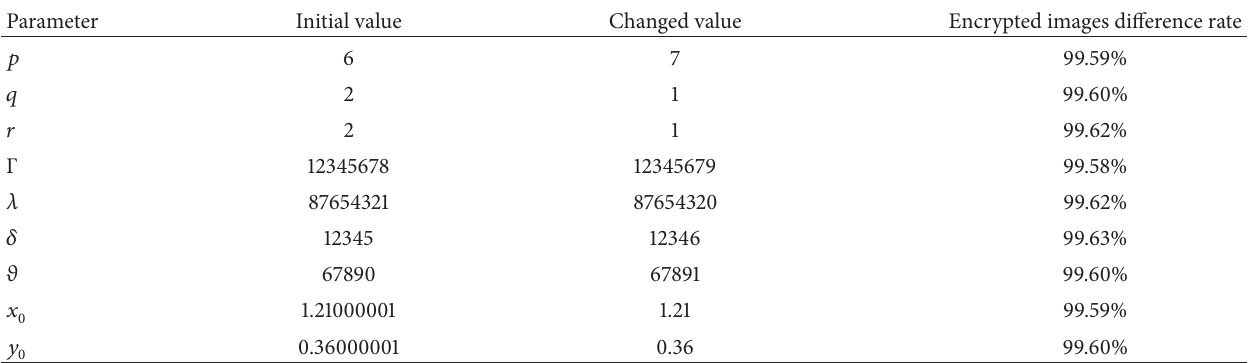
Table 6: Difference rates of two encrypted images with slight change in a